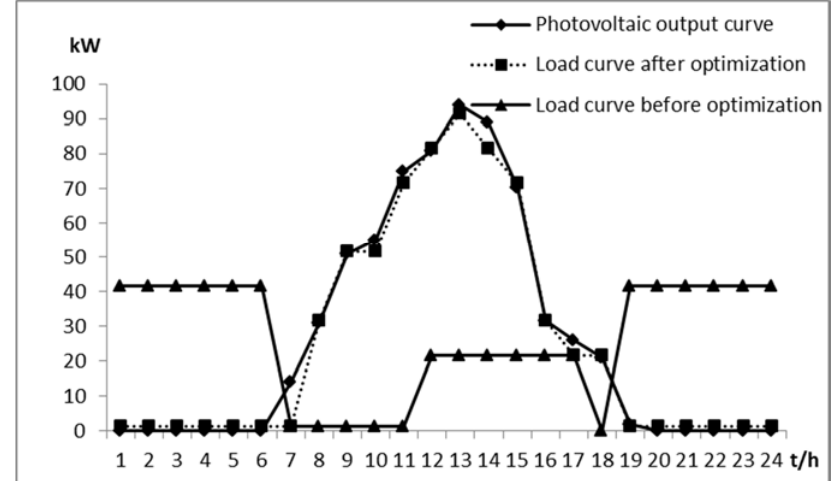
Figure 9. Comparison curve of load before and after optimization on a cloudy winter day after a sunny day.